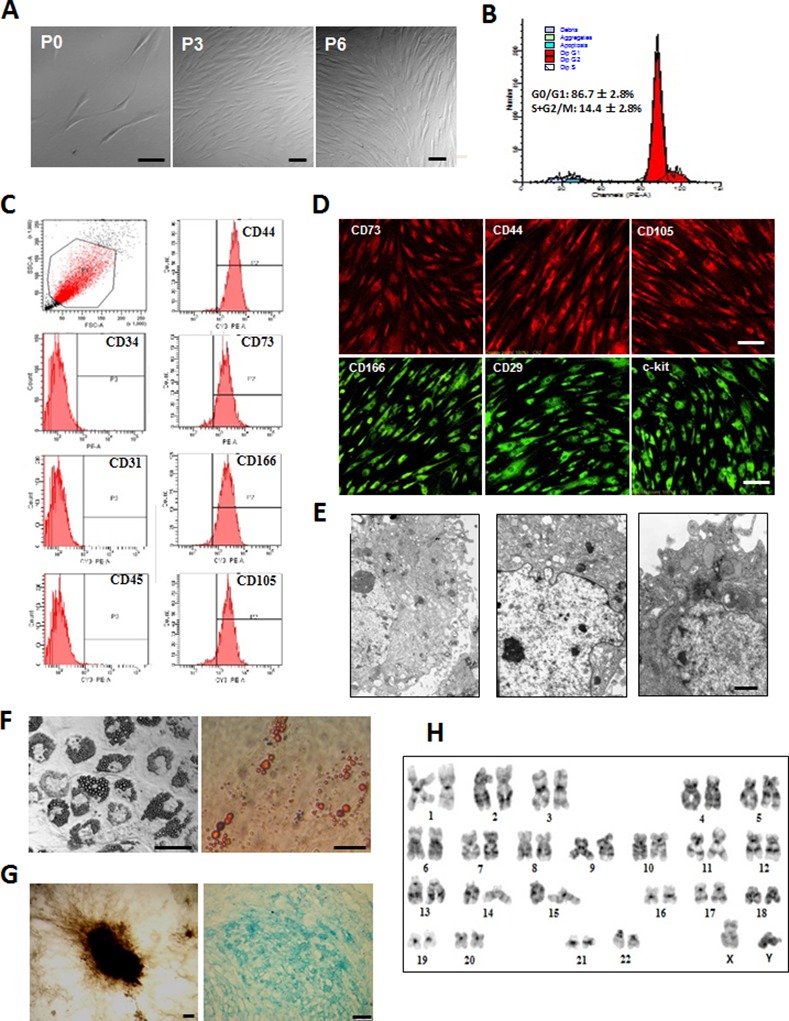
The morphological and phenotypical characteristics of cultured human bone marrow mesenchymal stem cells (hMSCs).Human bone marrow samples were obtained from healthy volunteers by lumbar puncture. Bone mononuclear cells were isolated from human bone marrow samples by density gradient centrifugation in a Percoll solution (1.073 g/ml) and cultured in L-DMEM with 10% fetal bovine serum. Eight to twelve days later, individual colonies were selected and subcultured. The morphology of cultured cells was observed and the 5th passages (P5) cells were used to identified the phenotypical characteristics. A: The morphological features of cultured hMSCs at 5th days, the 3rd and 6th passages. B: Cell cycle analysis revealed that most of P5 hMSCs were in the G0/G1 phase (quiescent phase, 86.7 ± 2.8%) with a small population of cells in the S+G2/M phase (active proliferative phase, 14.4 ± 2.8%). C: Flow cytometry analysis disclosed that P5 hMSCs were positive for CD44, CD73, CD166 and CD105, but negative for CD34, CD31, and CD45. D: Immunofluorescence staining showed almost all of P5 hMSCs expressed the antigens of CD73, CD44, CD105, CD166, CD29 and c-kit. E: Under transmission electron microscope, hMSCs exhibited abundant microvilli on cell surface (upper), the irregular shape of nucleus with plentiful euchromatin (middle) and abundant organelles and glycogen granules in cytoplasm (bottom). To detect multi-lineage differentiation potential, P5 hMSCs were cultured in adipogenic, osteogenic, or chondrogenic medium for 2–4 weeks. F: After the induction, lipid droplets in cytoplasm and Oil-Red-positive adipogenic cells were observed. G: The osteogenic differentiation of hMSCs was demonstrated by mineral deposits formed and positive Von Kossa staining (left). The chondrogenic differentiation was reflected by positive Alcian blue staining (right). H: Karyotype analysis revealed the normal karyotype of P5 hMSCs. Scale bars: 50 μm for A, D, F, G and 1 μm for E.